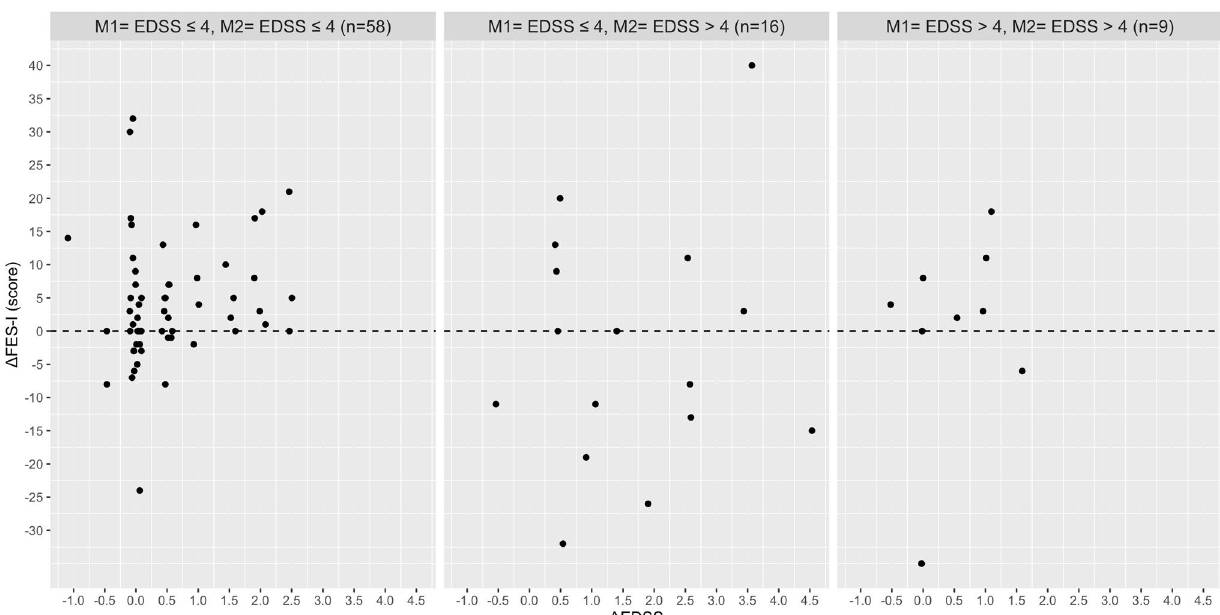
Figure 6. Relationship between the absolute change in the FES-I with absolute change in the EDSS score according to disability